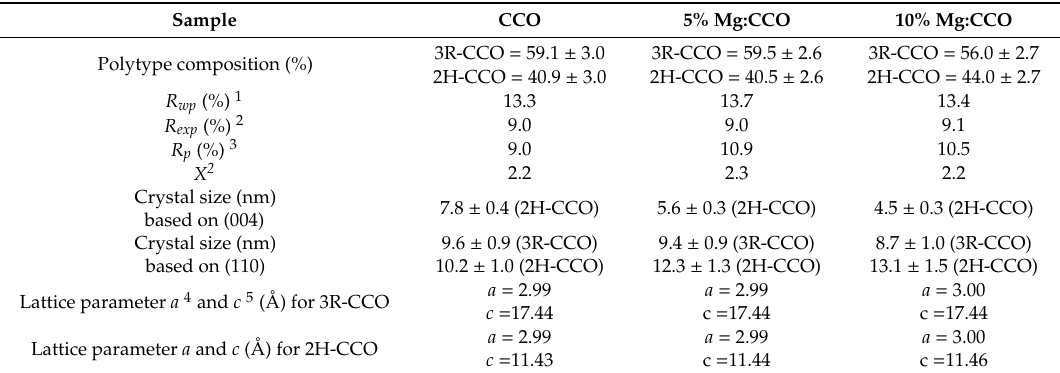
Lattice parameter a and c (Å) for 2H-CCO